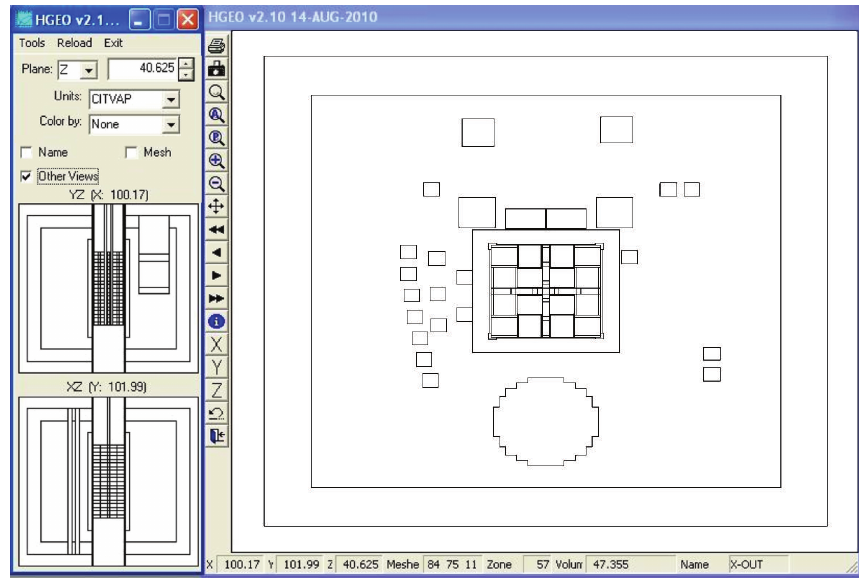
Figure 6: Example visualization of a CITVAP input model using HGEO.